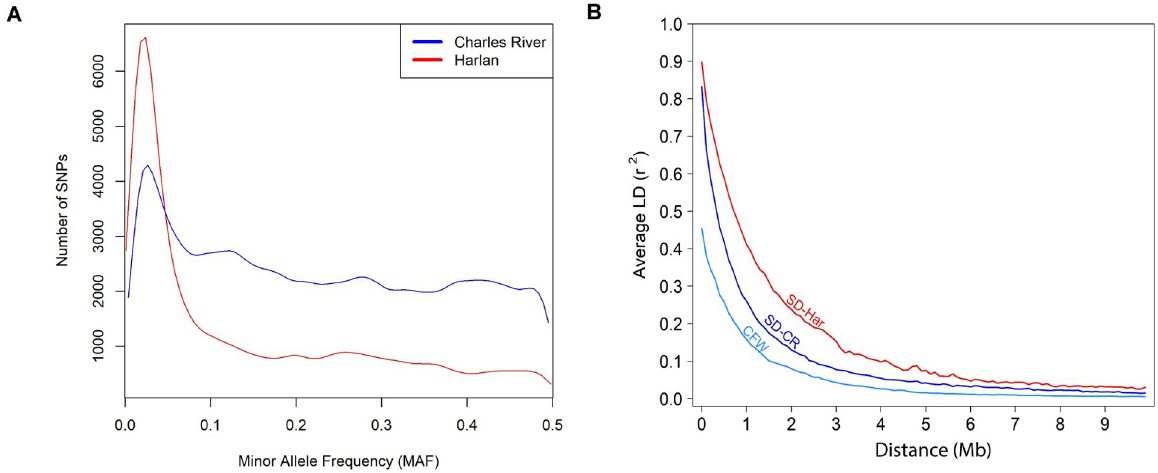
Fig 3. SNP MAF distributions and comparison of linkage disequilibrium decay rates. (A) Density curves of minor allele frequencies for 214,309 SNPs in Charles River and 114,568 SNPs in Harlan, after removing SNPs with MAF < 0.01. (B) Linkage disequilibrium decay rates in SD rats from both vendors and outbred Swiss Webster (CFW) mice.